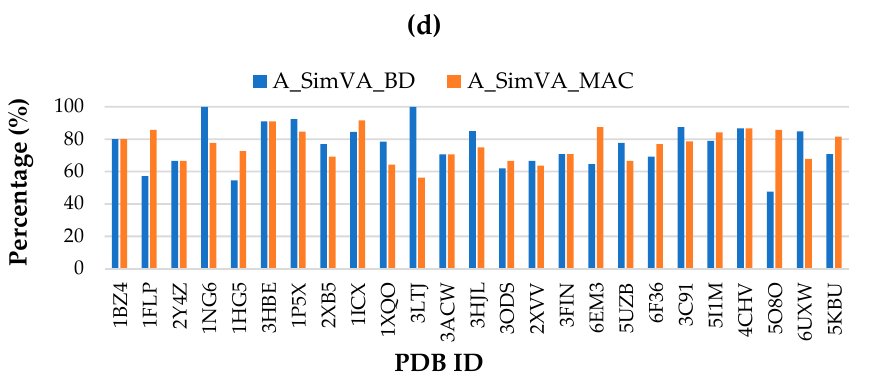
Figure 5. Assessment of the method concerning the performance measurements: ( a ) precision, ( b ) sensitivity, ( c ) F-measure, ( d ) accuracy.